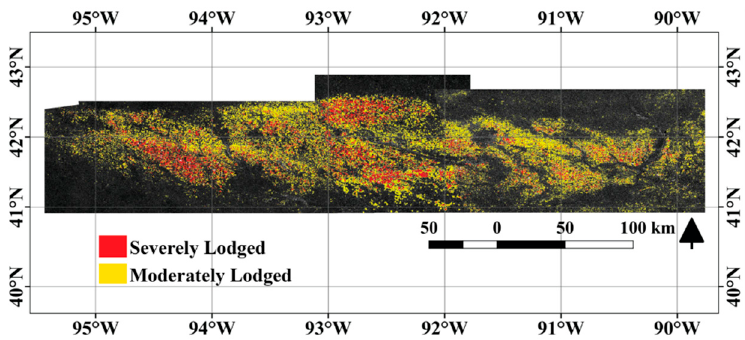
Figure 8. Spatial mosaic of all lodging maps in Figure 7a–c. Table 2. Amount of lodged corn and soybean per unit area.